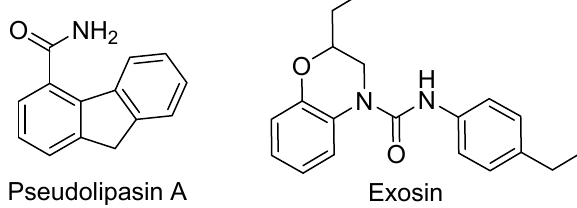
Figure 17. Structure of pseudolipasin A and